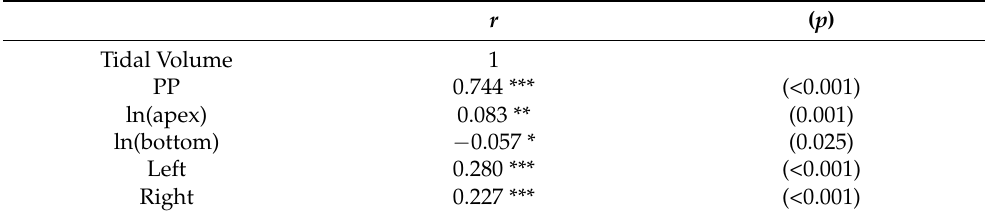
Table 3. Correlation between the tidal volume, peek pressure, and 4-spot adhesion strengths.